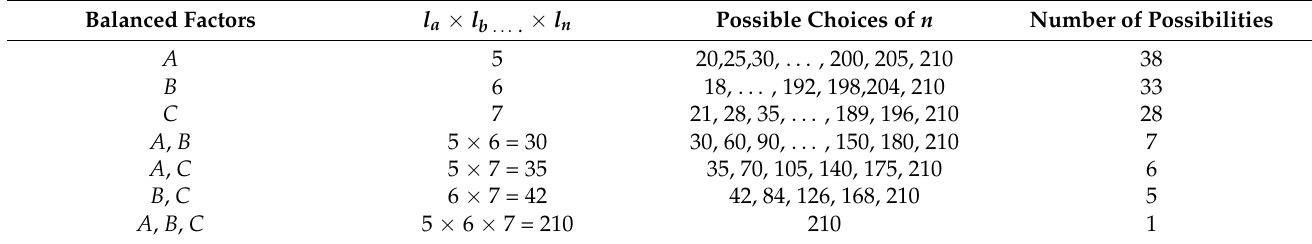
Table 4. Several possibilities of size fraction for D(5 1 6 1 7 1 ) with qualitative